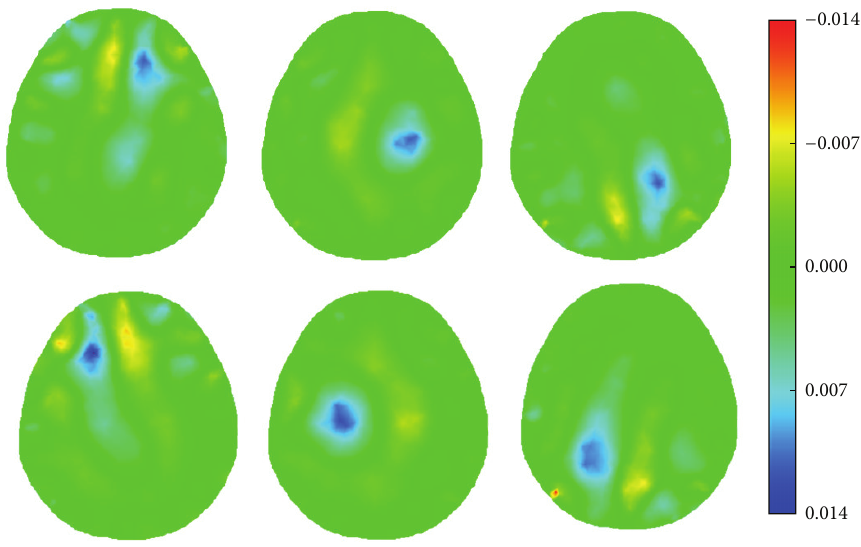
Figure 20: SEIT reconstructions of the simulated ischemic stroke lesion at different locations of the 2D head